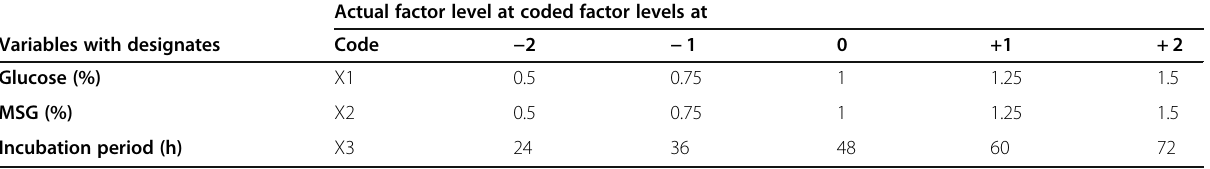
Table 1 Experimental range and levels of independent variables Actual factor level at coded factor levels at Variables with